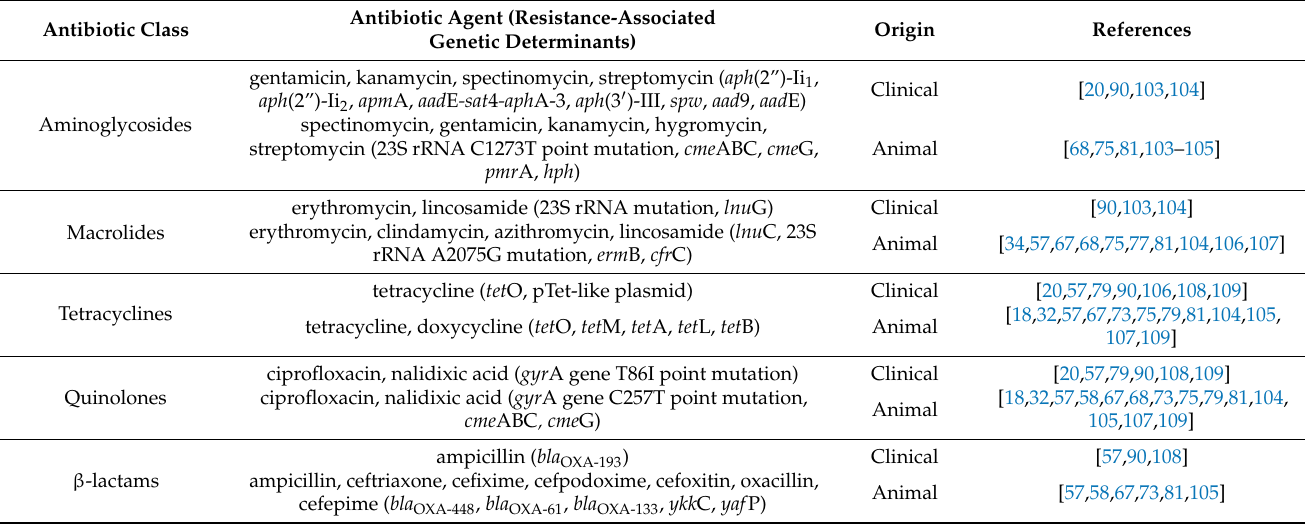
Table 2. Examples of antibiotic agents present in multidrug-resistant C. jejuni / C. coli recovered from clinical and animal